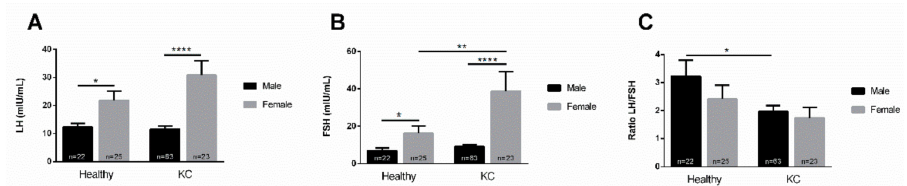
Figure 2. Gender-dependent expression of LH, FSH, and LH / FSH ratio in healthy and KC blood (plasma) samples. ( A ) Healthy male (n = 22), healthy female (n = 25), KC male (n = 63) and KC female (n = 23) LH levels; ( B ) healthy male (n = 22), healthy female (n = 25), KC male (n = 63) and KC female (n = 23) FSH levels; and ( C ) the male and female LH / FSH ratio, in healthy controls and KCs. * p < 0.05, ** p < 0.01, **** p < 0.0001. (See Supplementary Materials—Figure S2).